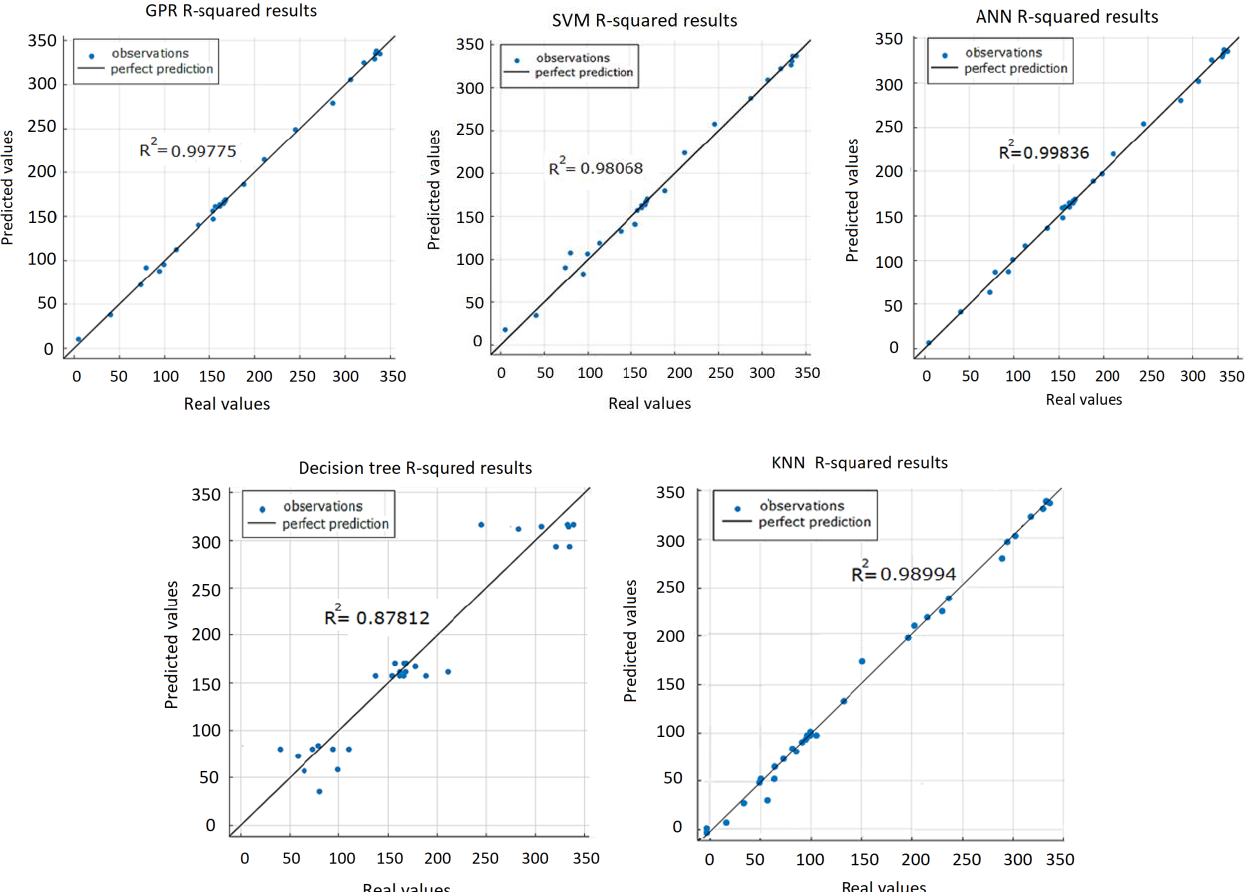
Figure 19. R-squared representation for all five ML algorithms used for the prediction task.